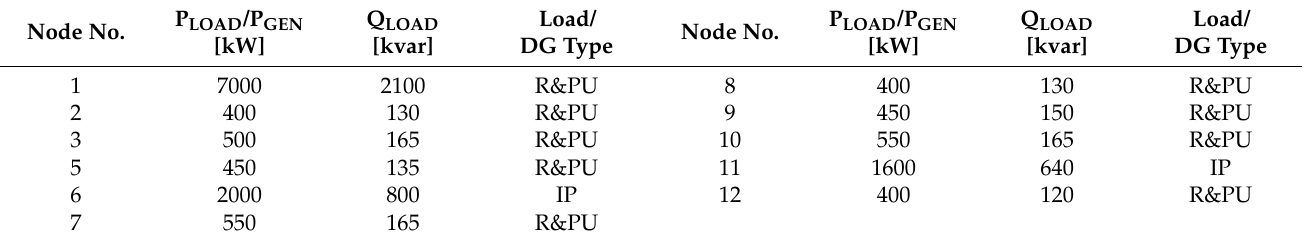
Table A8. Line parameters of the actively managed MV distribution network. From To From To Length [m] Node No. Node No. Node No. Node No.